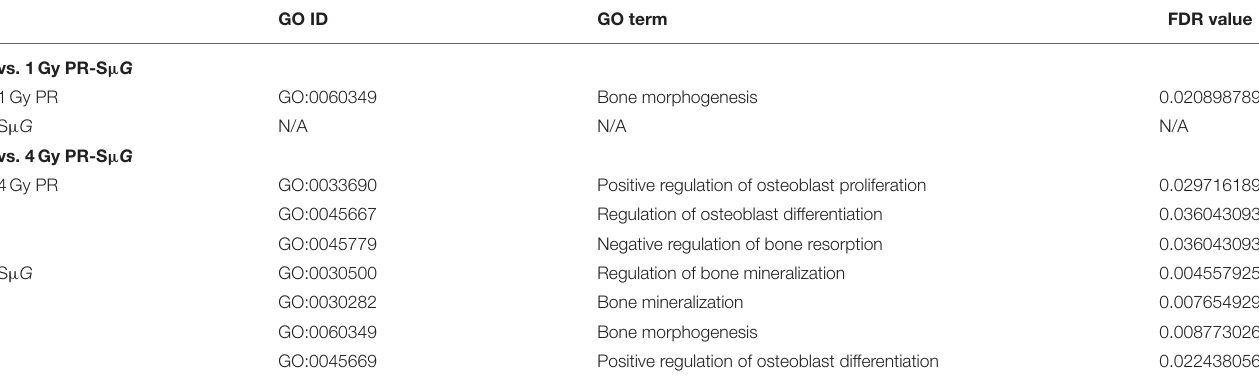
TABLE 1 | List of gene function annotations related to PR and/or S µ G